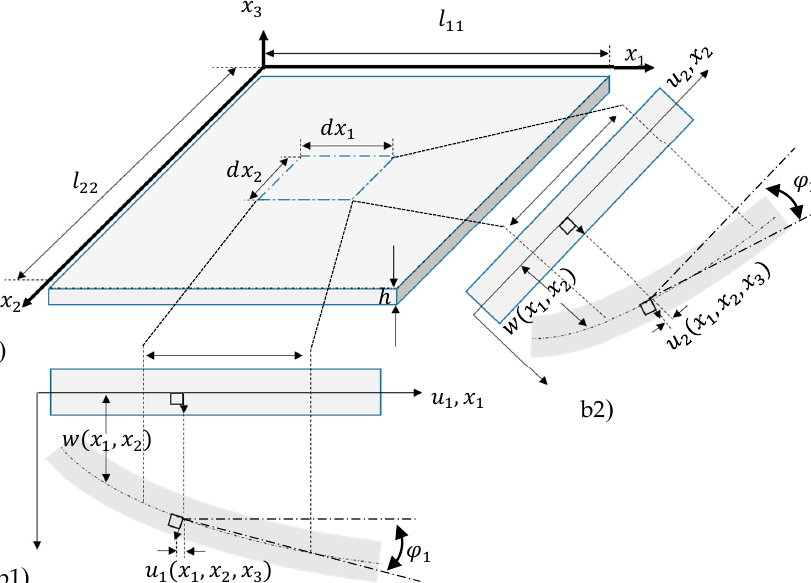
Figure 3. ( a ) Plate with thickness h and cut-out plate element, deformed and undeformed state in ( b1 ) x 1 - and ( b2 ) x 2 -direction (adapted from Reference